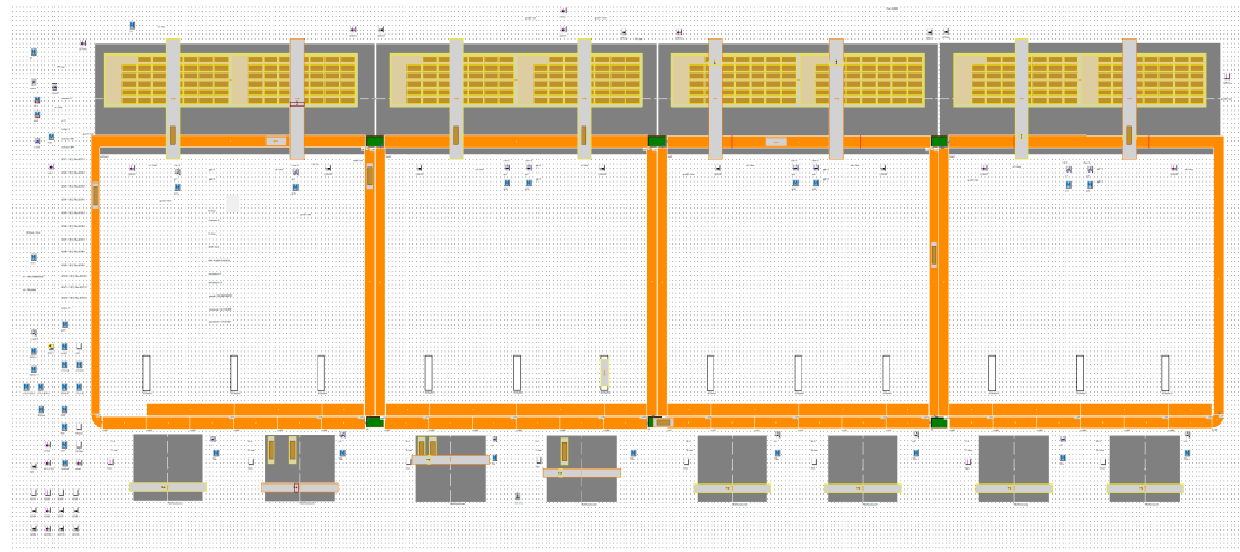
Figure 5. Schematic of the automated container terminal considered in the case studies.